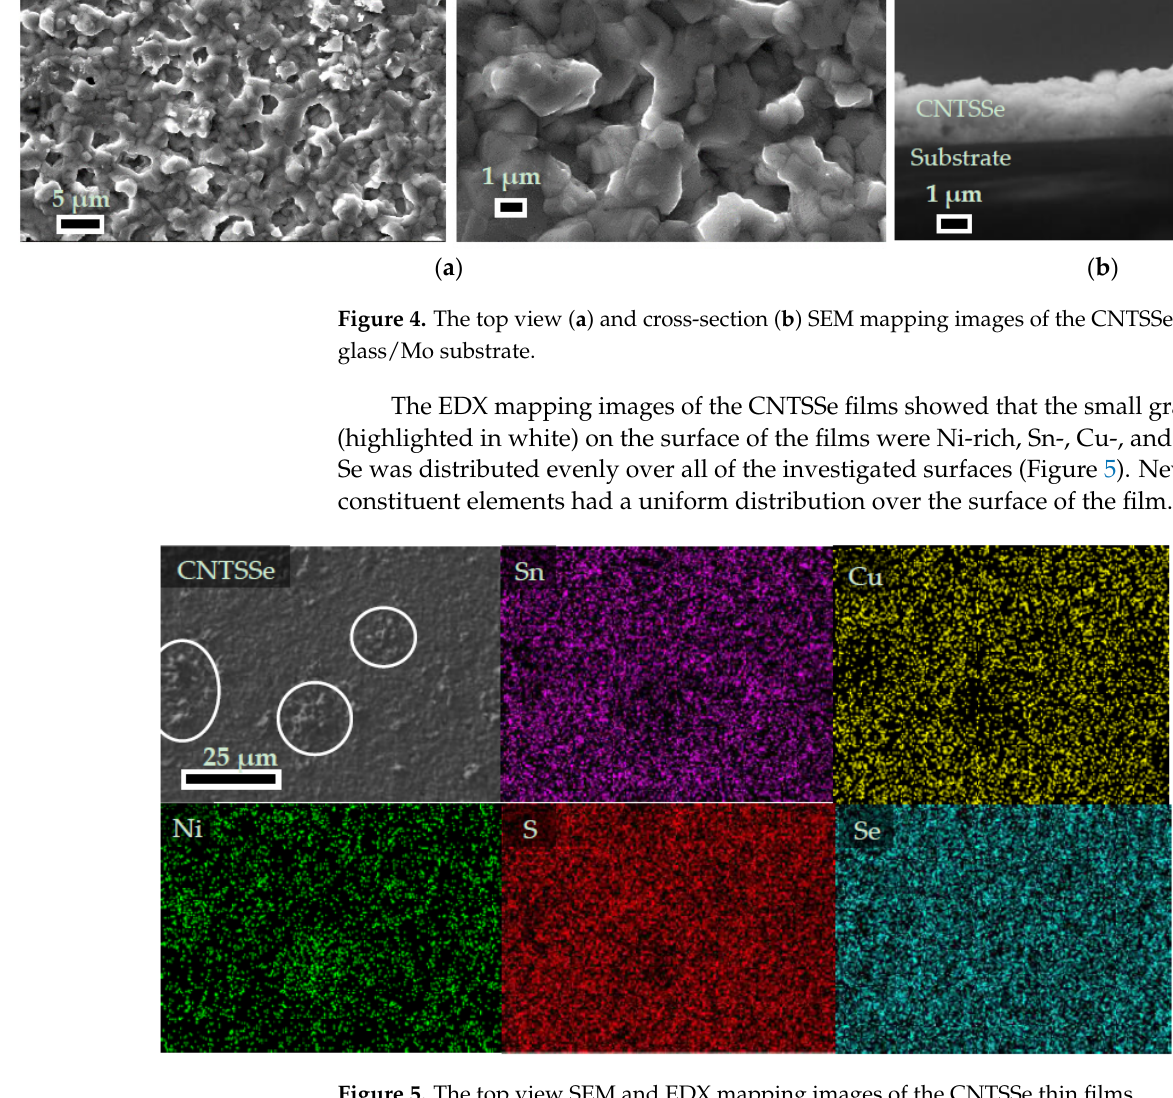
Figure 5. The top view SEM and EDX mapping images of the CNTSSe thin films.